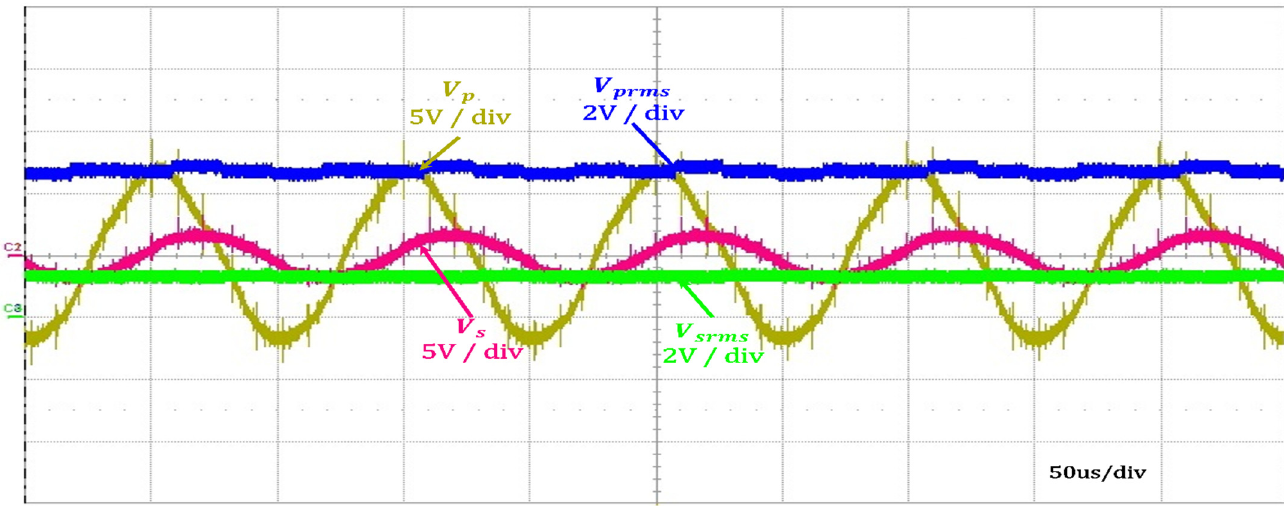
Figure 7. Primary winding and secondary winding voltage results of the filament in the insulating transformer. (Note: V p : 1st wind voltage, V s : 2nd wind voltage, V prms : 1st wind voltage rms value, V srms : 2nd wind voltage rms value ).